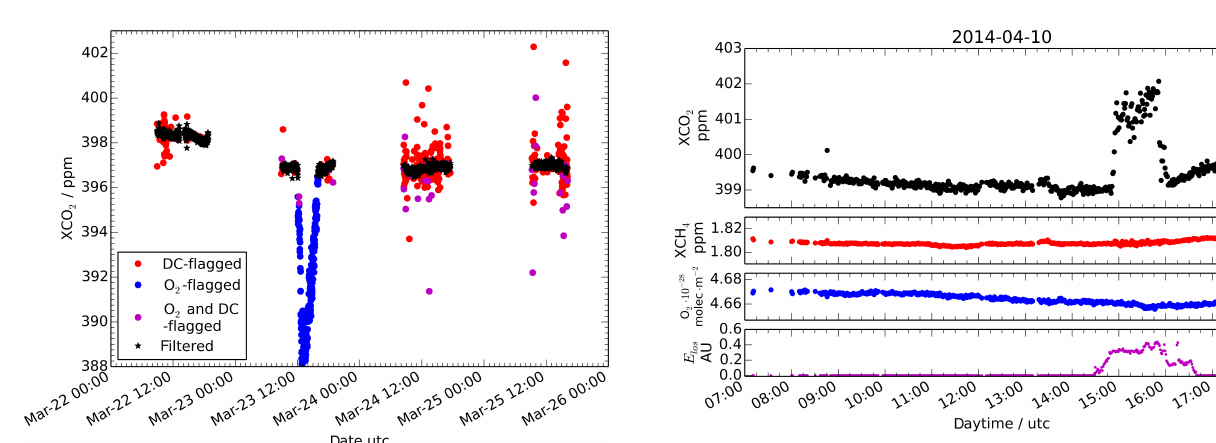
Figure 4. Effect of the DC filter and the O 2 filter on the retrieved XCO 2 for 4 sample days during the campaign. The outlier on 23 March that is caught by the O 2 filter originates from a malfunction of the sun tracker that caused unstable pointing. The days after were affected by small but opaque clouds that disturbed some measure- ments which are caught by the DC filter.